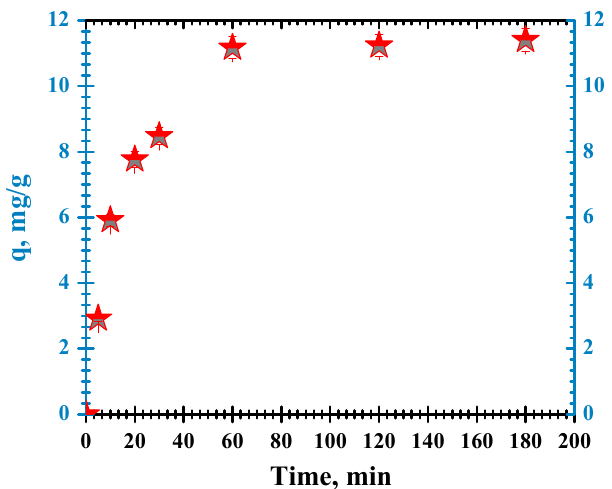
Figure 9. Congo Red dye adsorption vs. contact time.